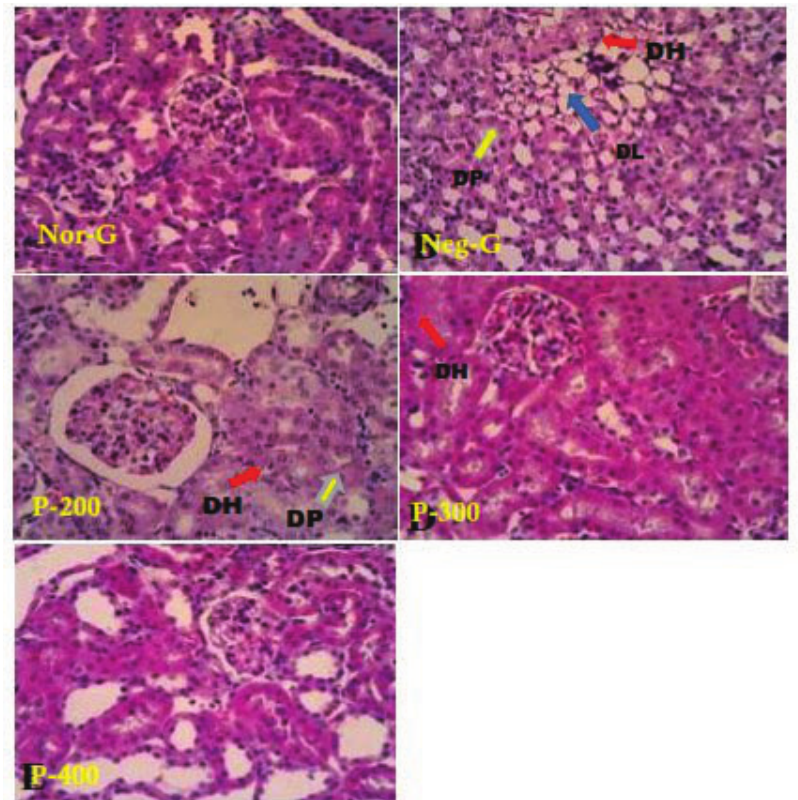
Figure 1. Kidney morphology in Nor-G (a control rat), Neg-G (rat treated with gentamicin alone), P-200 (rat treated with gentamicin + pruslane extract at the dose of 200 mg/Kg BW), P-300 (rat treated with gentamicin + pruslane extract at the dose of 300 mg/Kg BW), P-400 (rat treated with gentamicin + pruslane extract at the dose of 400 mg/Kg BW). DH: Hydropic degeneration, DP: parenchymatous degeneration, DL: lipid degeneration (Haematoxylen & Eosin × 400).